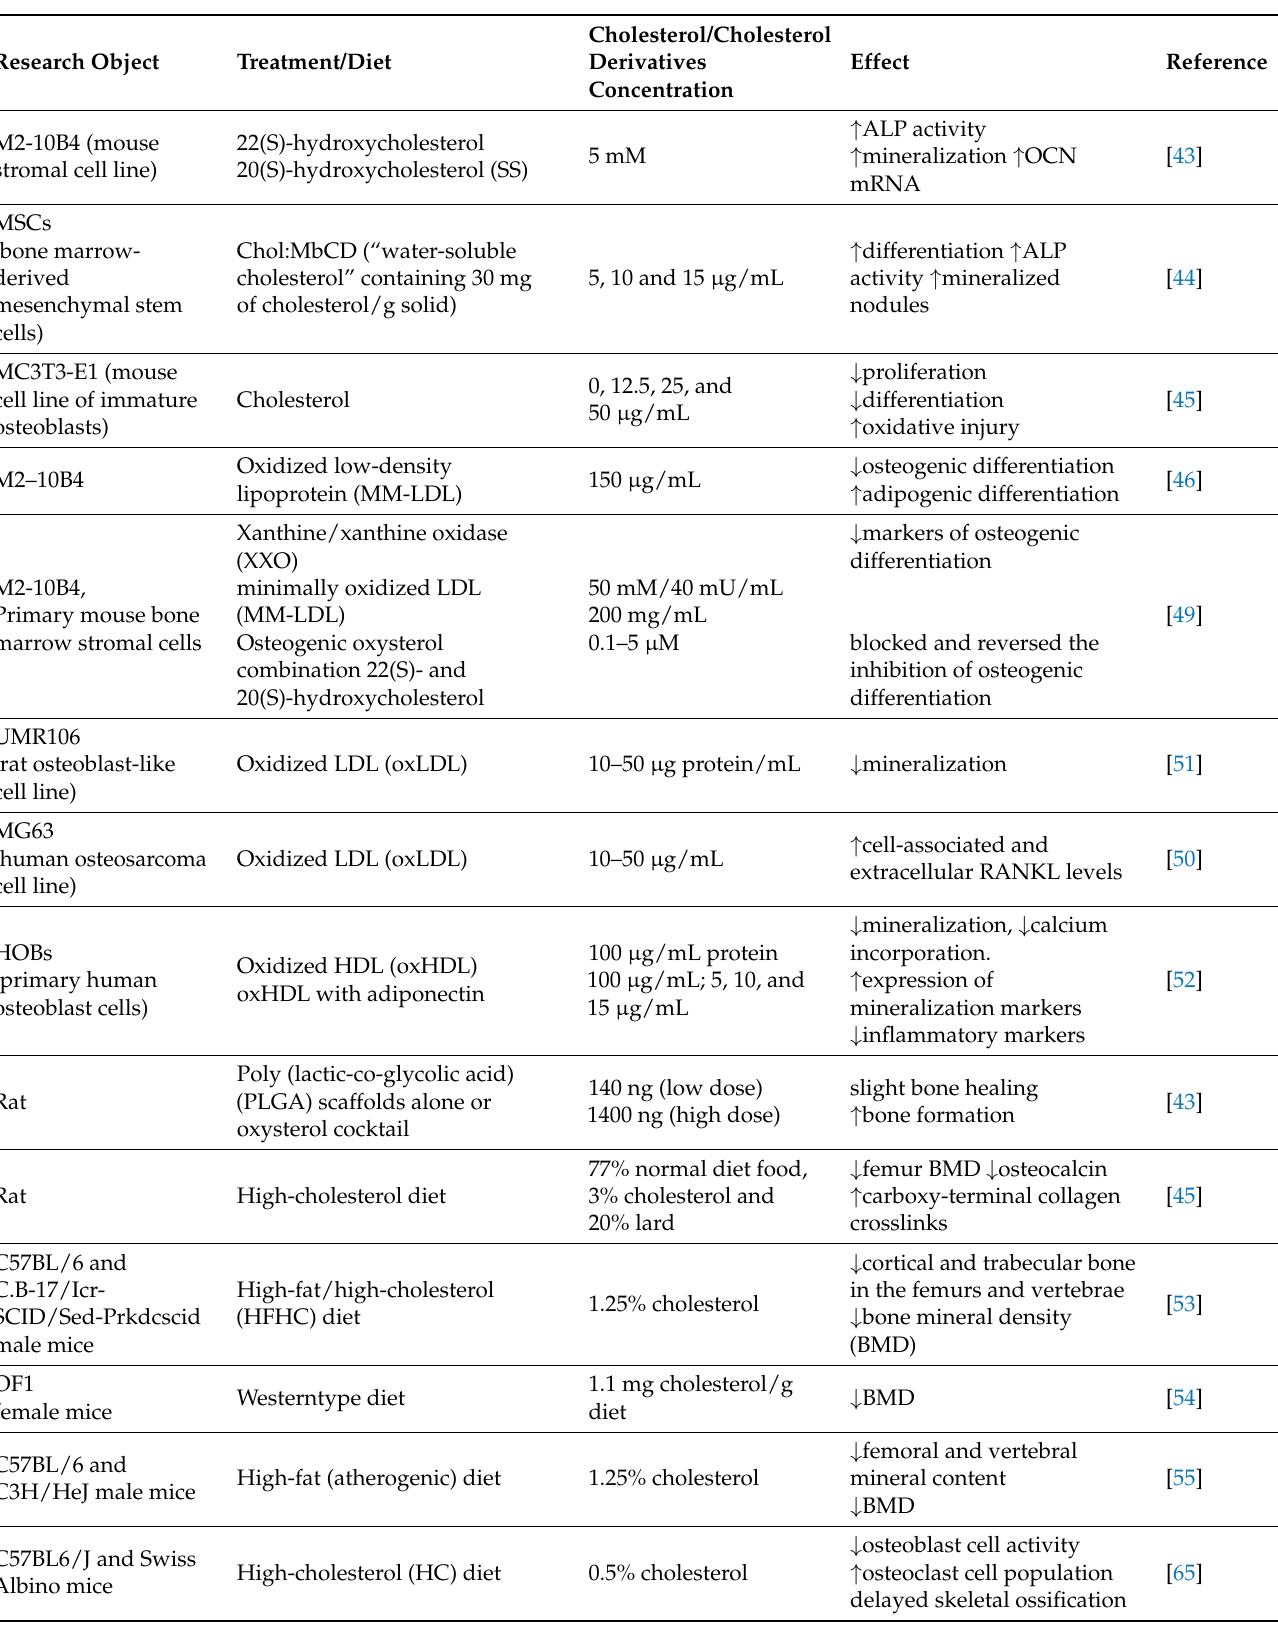
Table 1. Effect of cholesterol on osteoblast proliferation and